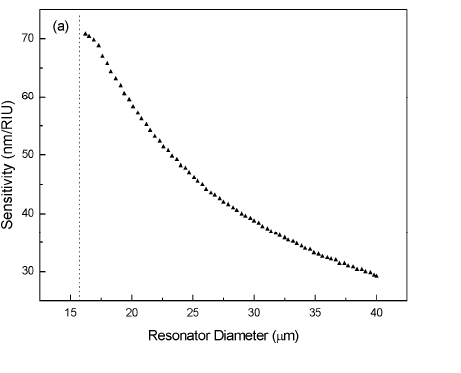
=1.426, n =1.47, n =1.0, d =0.4 1 2 3